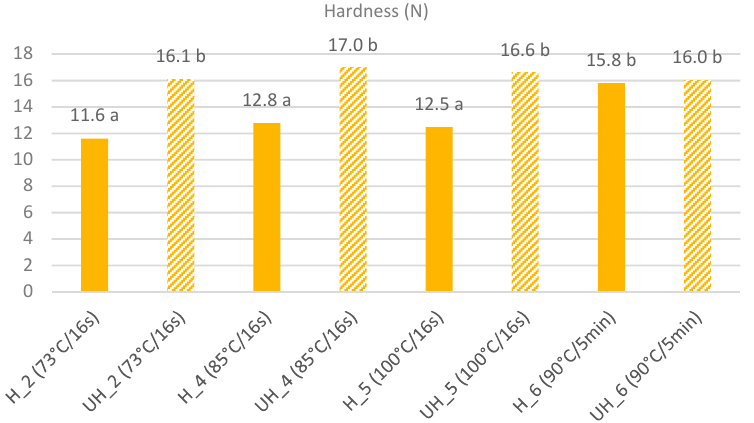
Figure 2. Interaction of homogenization and heating conditions on the hardness of Quark-type cheeses; a,b indicate significant differences (LSD, p < 0.05).